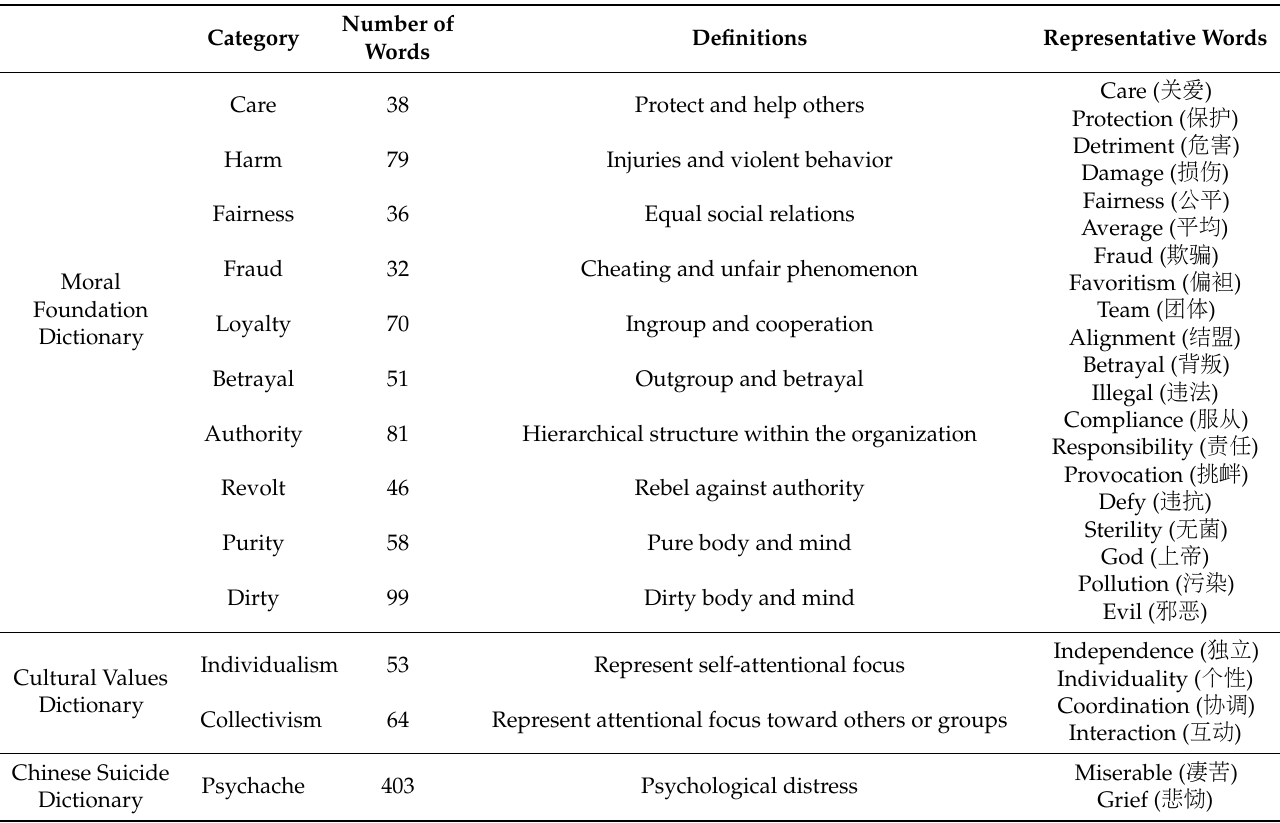
Table 2. Detailed description of the